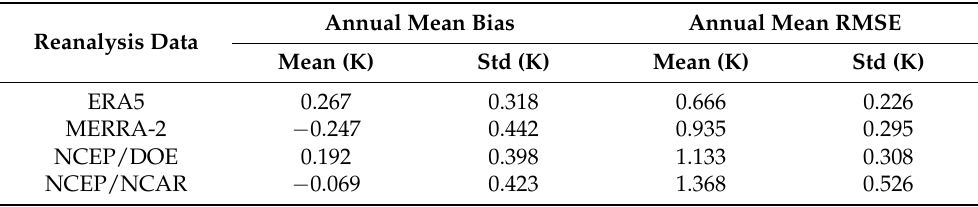
Table 4. Mean values and standard deviation of the annual mean bias and RMSE of T m derived from four reanalysis data from 2005 to 2019.